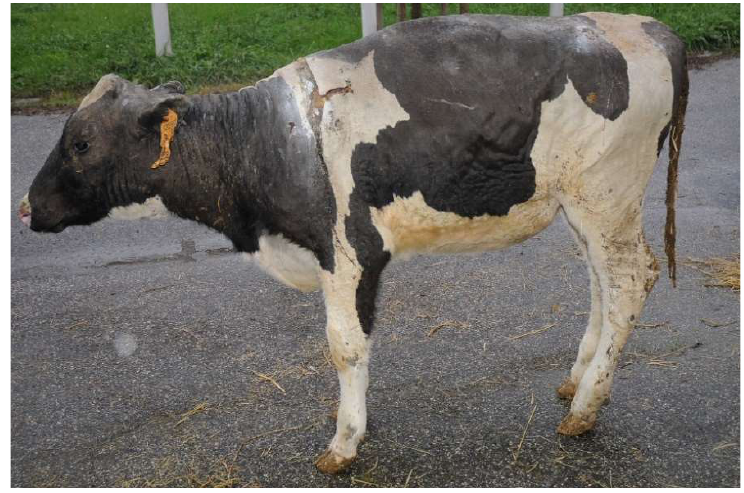
Figure 3. Heifer 1’s skin lesions three days after admission. Note the disjunction at the level of the fissure present on the neck and the thickening of the skin at the level of the ribs and abdomen.